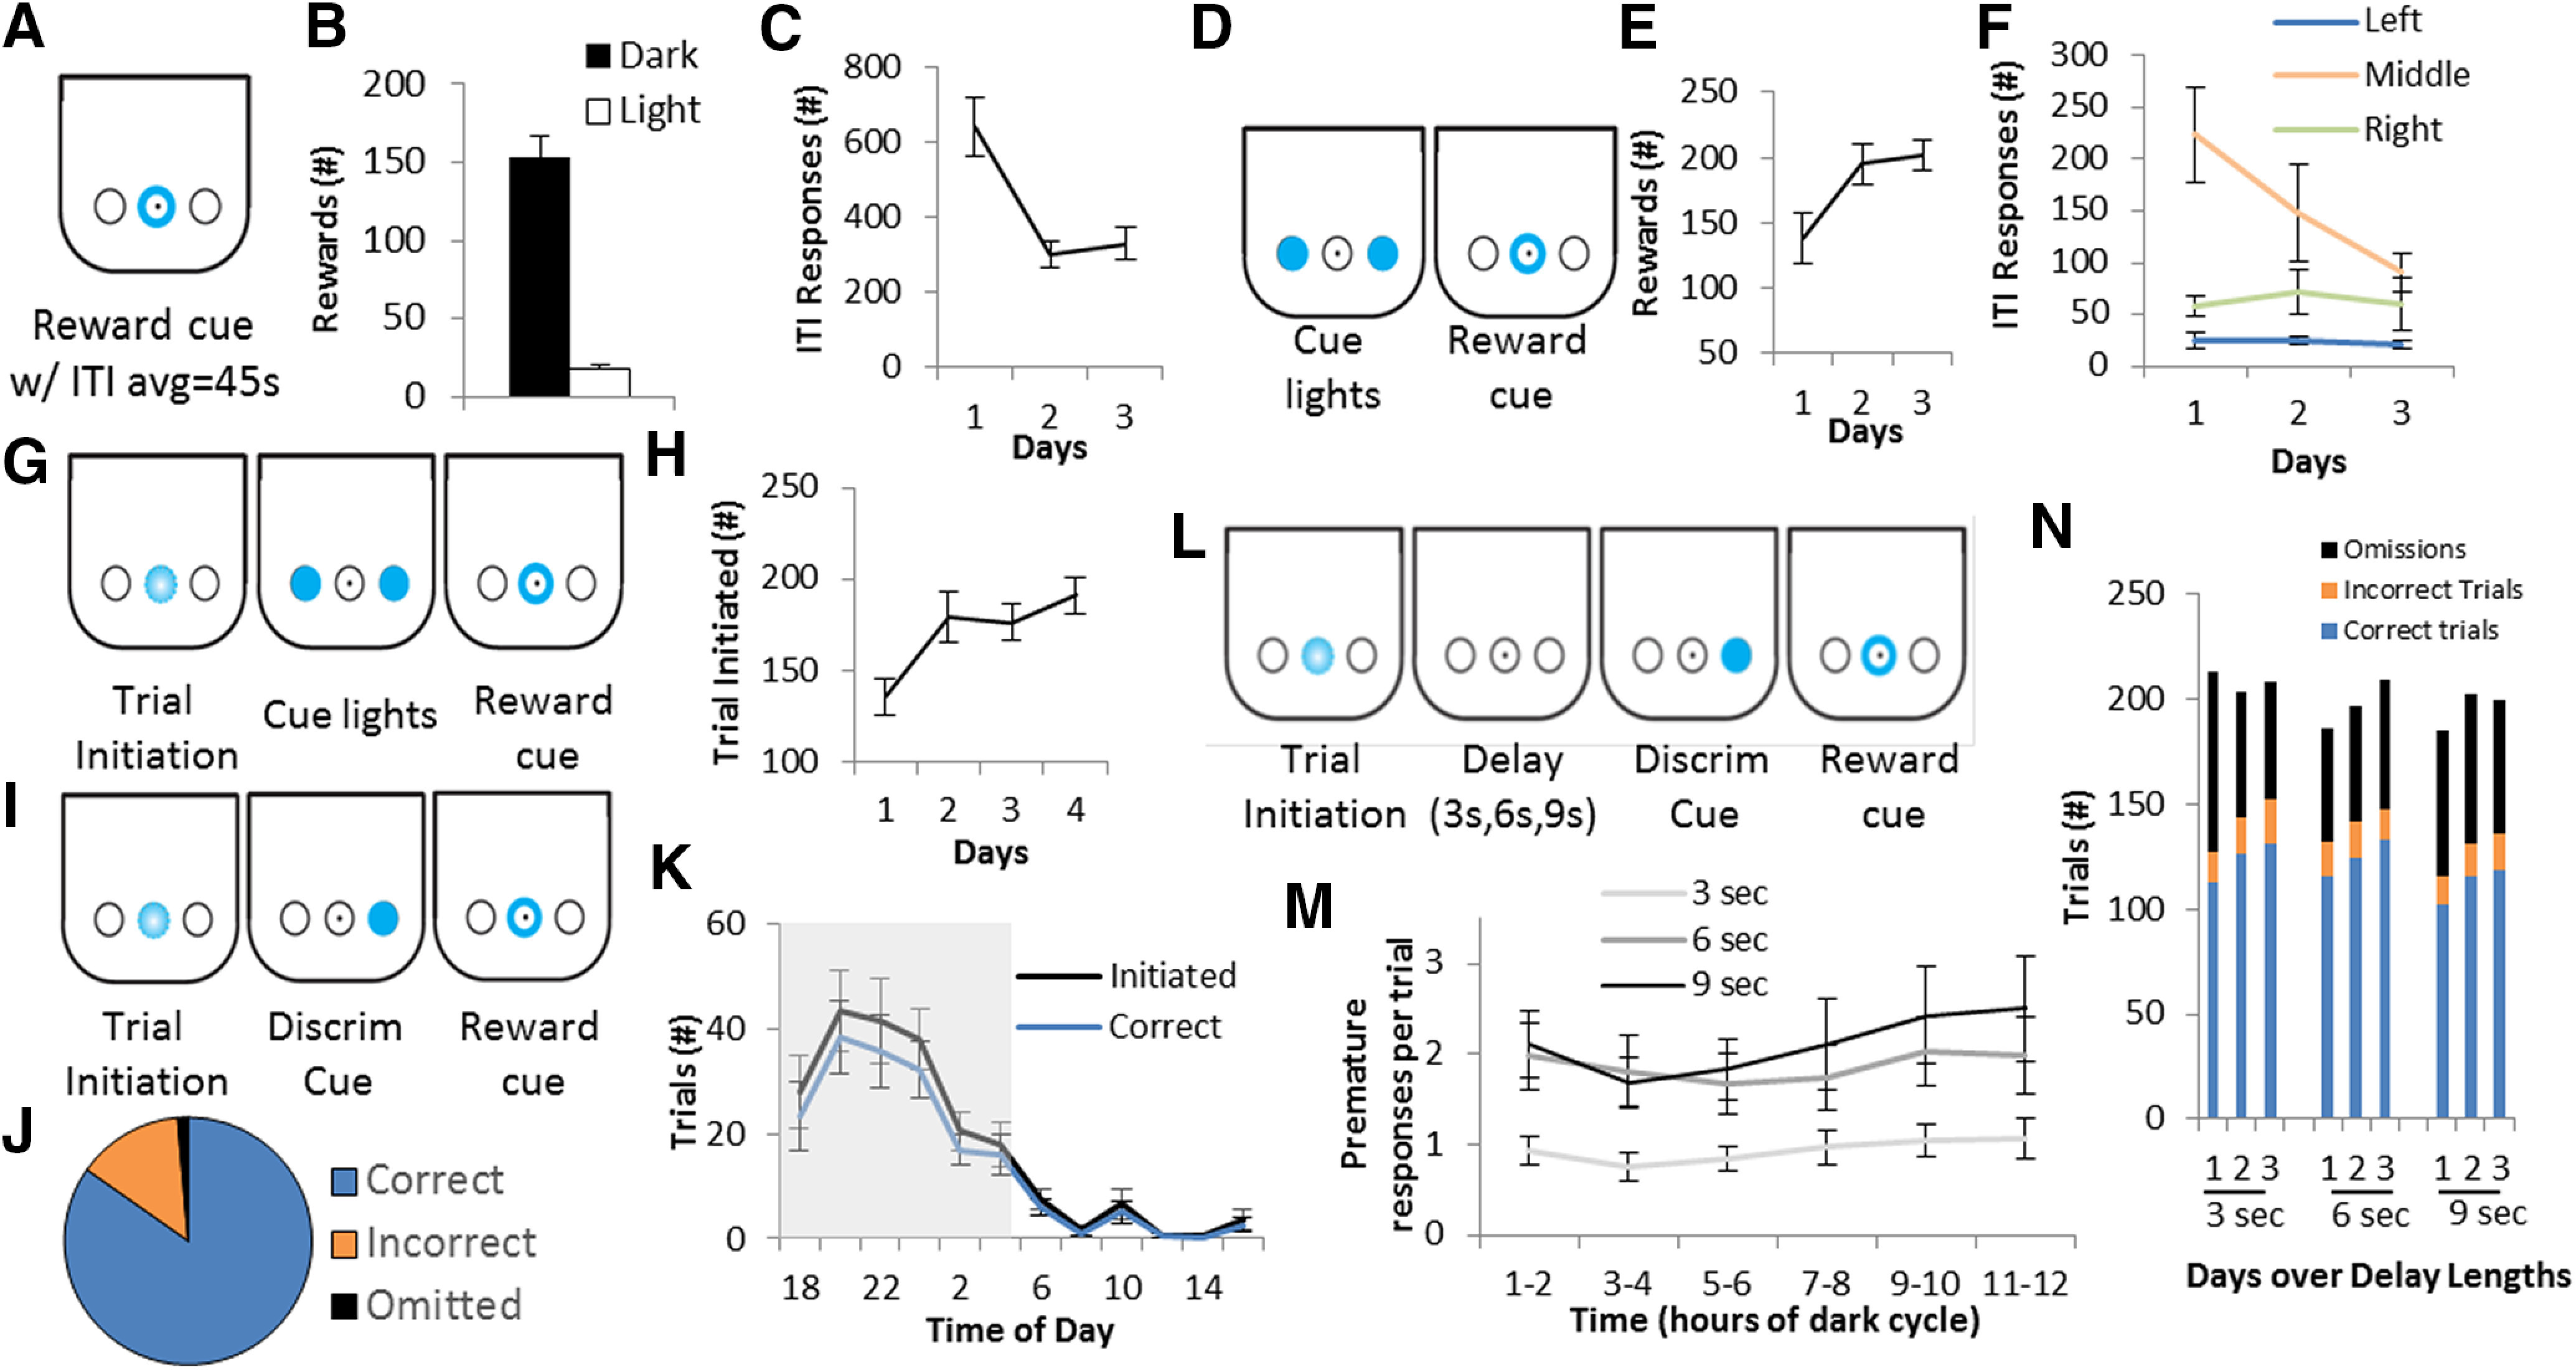
Measuring operant behavior with the DIY-NAMIC system. A, Reward retrieval training (P1) occurred with presentations of reward available in trials with an ITI average of 45 s. Schematic shows the center reward port is illuminated when the reward is available. B, The number of rewards retrieved over 3 d is shown, separated by light and dark cycle. C, Number of pokes during the ITI when the reward is unavailable is shown over 3 d. D, Schematic for continuous reinforcement training (P2) shows that both side ports are illuminated during a trial, and pokes to either results in reward availability. E, The number of rewards received is shown across the 3 d of training. F, ITI responding is shown over 3 d for each noseport. G, Schematic for P3 which includes trial initiation shows how trials become self-initiated by a poke to the blinking center port. H, Number of self-initiated trials over 4 days of the paradigm. I, Schematic describes the operant cue discrimination paradigm (P4), in which the correct/rewarded port was illuminated by the LED. J, The group average shows that mice perform correctly on 85% of trials and have relatively few incorrect (14%) and omitted (1%) trials. K, The number of trials initiated and the number of correct trials are shown across 24 h, binned by 2 h. The shaded gray area indicates the dark phase of the light cycle. L, Schematic shows the modified two-choice serial reaction time task which was used to assay impulsive action. M, Three-day averages of premature responses per trial over three delay lengths, shown by 2-h bins over the dark cycle. N, Total number of correct, incorrect, and omitted trials on each of 3 d run on three delay lengths. All group averages are shown for N= 9 mice, with error bars representing SEM.